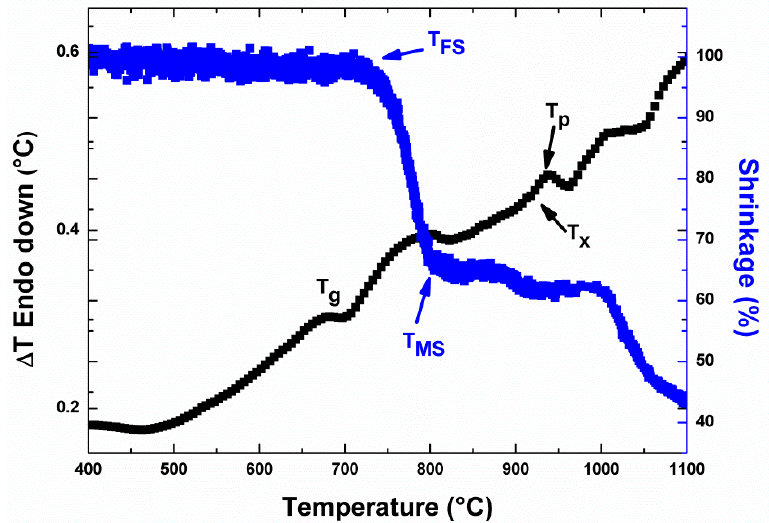
Figure 2. Differential thermal analysis (DTA) and heating stage microscope (HSM) curves of HJ28 as-casted glass. Analyses were carried out at 5 °C/min.